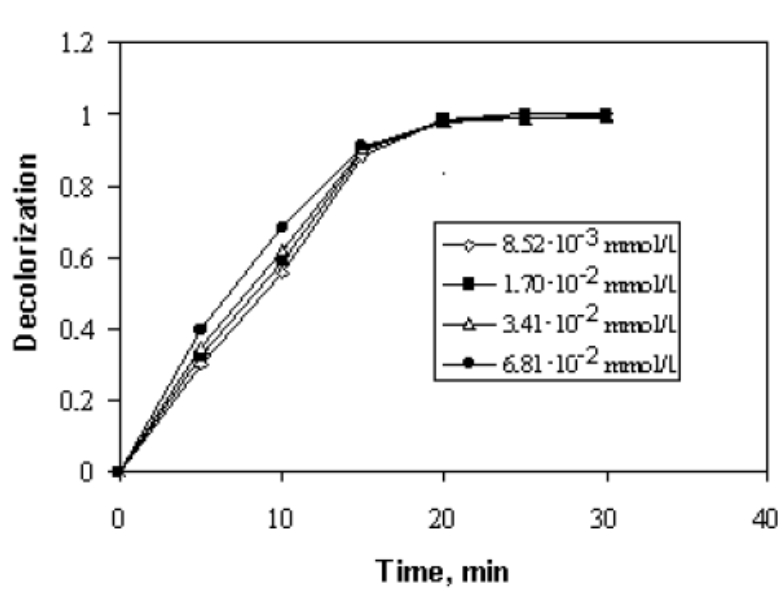
Fig. 15 Effect of Ni 2+ ions on AOP in alkaline medium. Initial conditions: C dye =50 mg/L, [H 2 O 2 ]= 17.318 mM.